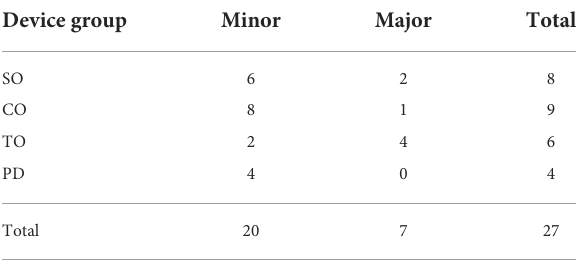
TABLE 5 Skin complication severity by device group in first 3